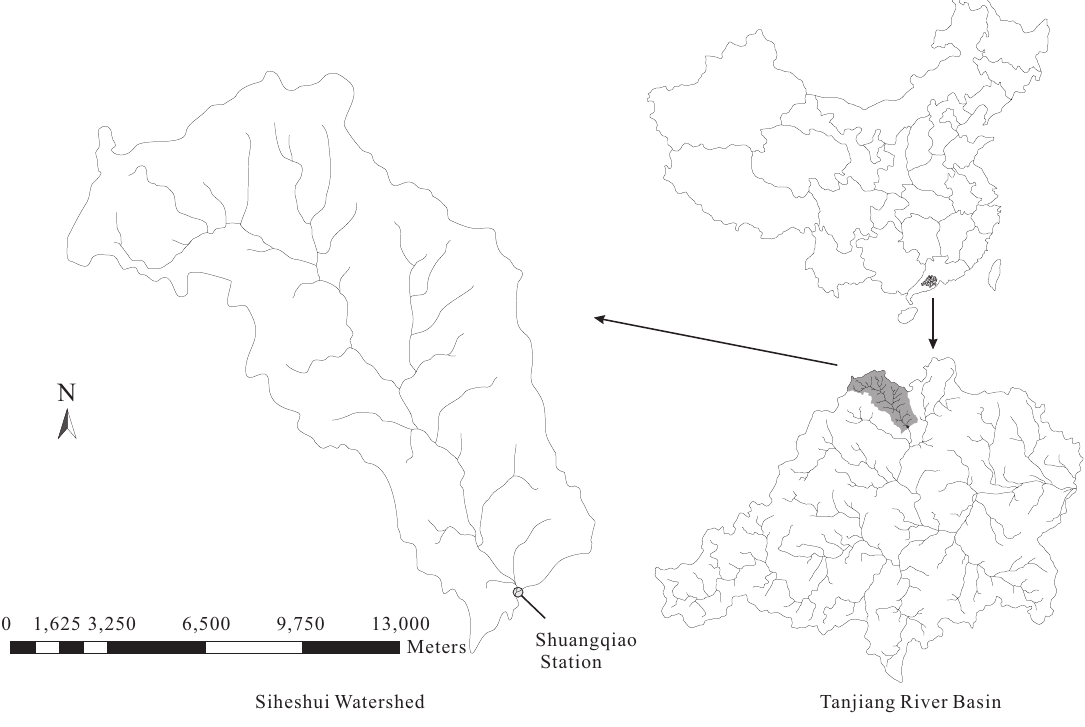
Figure 1. Sketch of the drainage map of Siheshui watershed in south